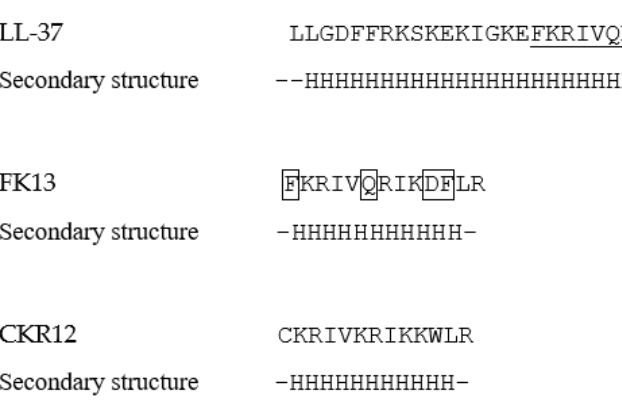
Figure 1. Predicted structures of LL-37, FK13, and CKR12. Fragmented sequence in LL-37 is underlined, and mutated residues in CKR12 are enclosed in the sequence of FK13. The predicted secondary structures are represented underneath the sequences as “H” for helical and “-” for random coiled structures.